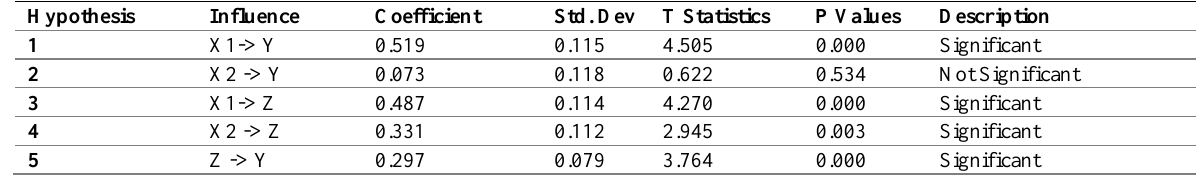
Table 6: The Results for Hypothesis Test in Direct